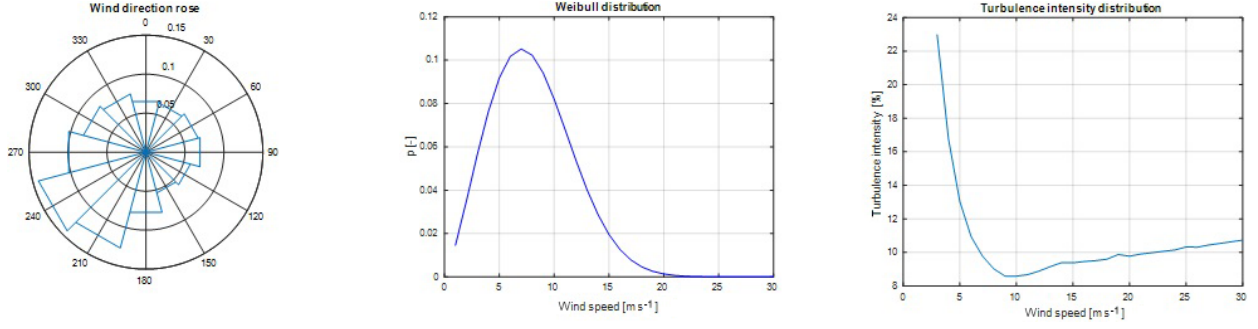
are pitch controlled, with a rotor diameter of 80 m and hub height of 80 m. The wind conditions at the site are given in Fig. 6: the wind direction distribution (left plot), wind speed distribution (middle plot), and turbulence intensity as a func- tion of wind speed (right plot). The measurements are ob- tained during normal operation, without misalignment, and therefore the focus here is on validation of the wake-induced load prediction capability of the LUT